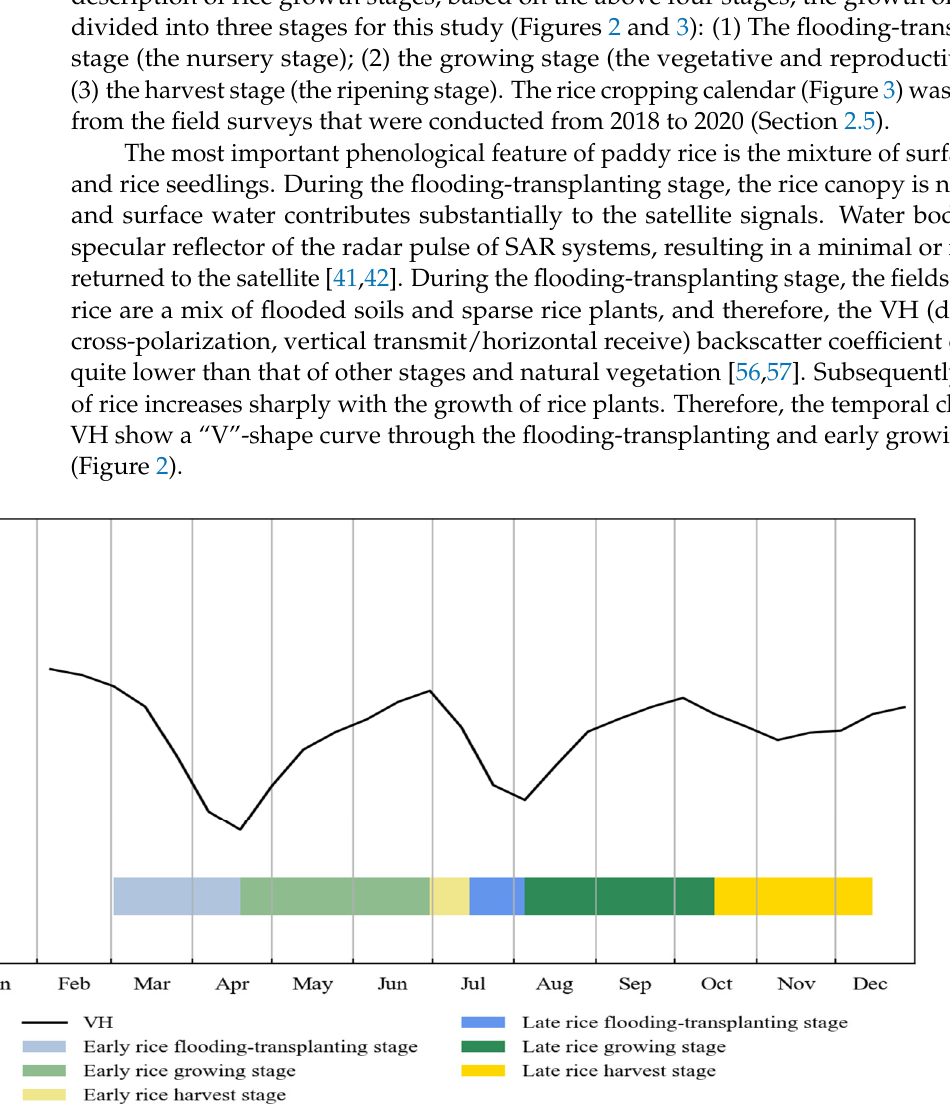
Figure 2. The temporal series of satellite-based VH at a double-season paddy rice sample site. VH: Dual-band cross-polarization vertical transmit/horizontal receive backscatter coefficient of SAR.